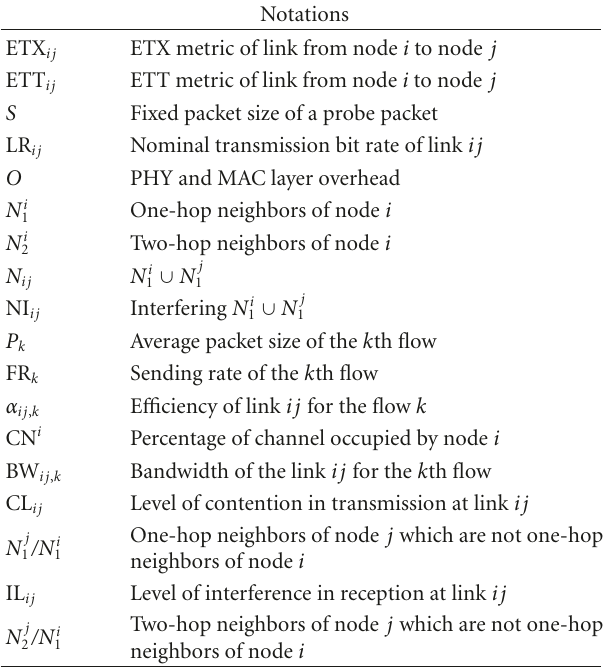
Table 1: Notations used in this